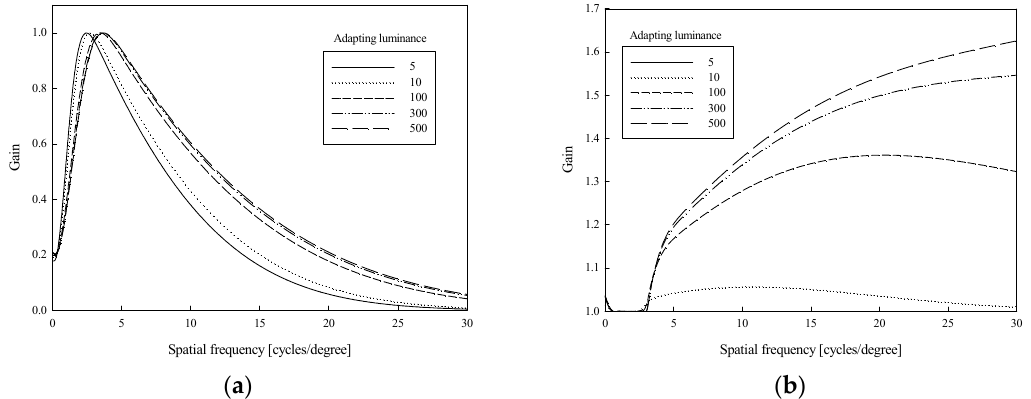
Figure 4. Proposed CSF and CSF sensitivity gain graphs. ( a ) Relative CSF graphs in Equation (4) and ( b ) CSF sensitivity gain graphs in Equation (13).